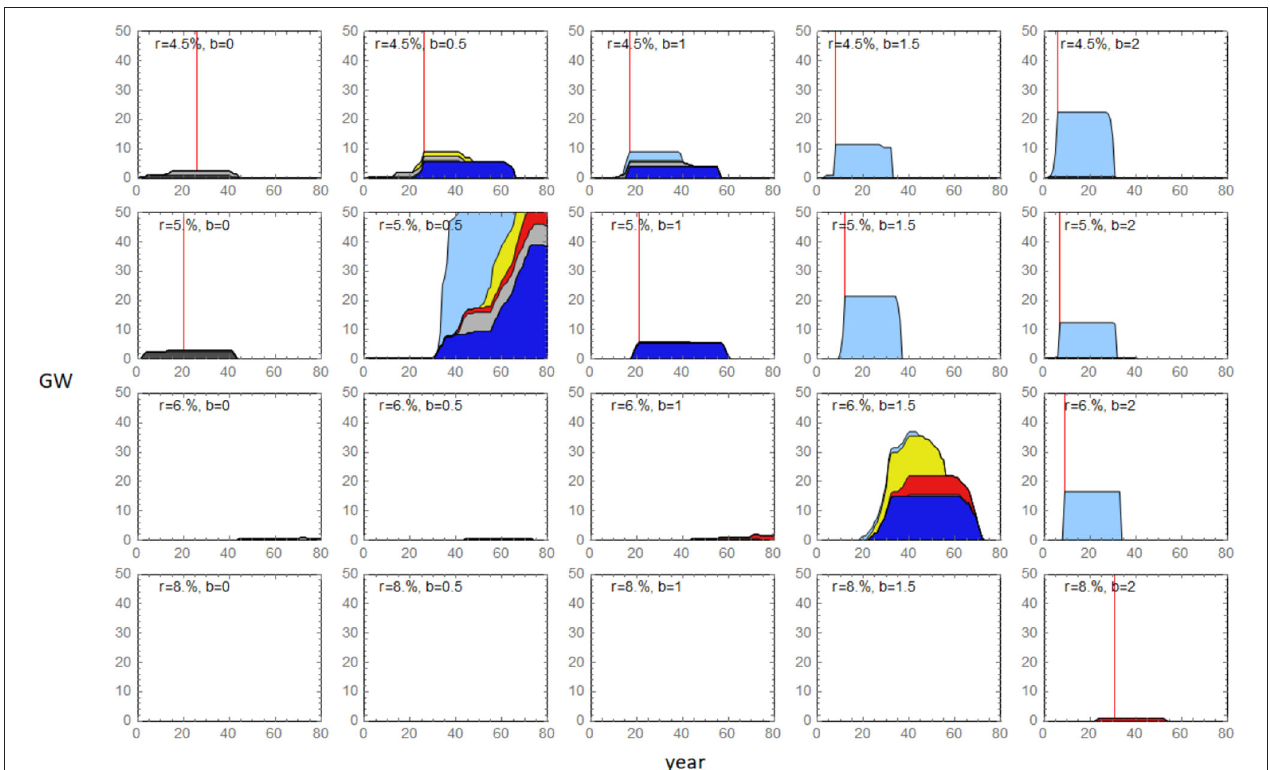
FIGURE 12 | The capacity mix of individual agents when the financial feedback module is implemented and f = 0% and i = 400M e . f is the fraction of an investment financed by a company’s own capital, and i is the initial capital in a company’s bank account. The vertical red line indicates the year an agent goes bankrupt.